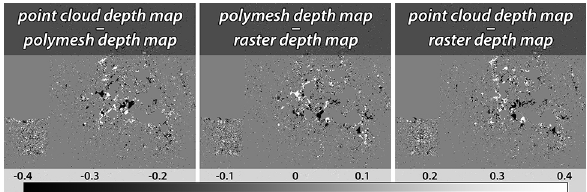
Figure 6 . Visualisation of the differences between 32-bit floating-point depth maps (of the same image) computed to generate a point cloud, a polymesh, and a raster. Even though Metashape produces slightly different depth